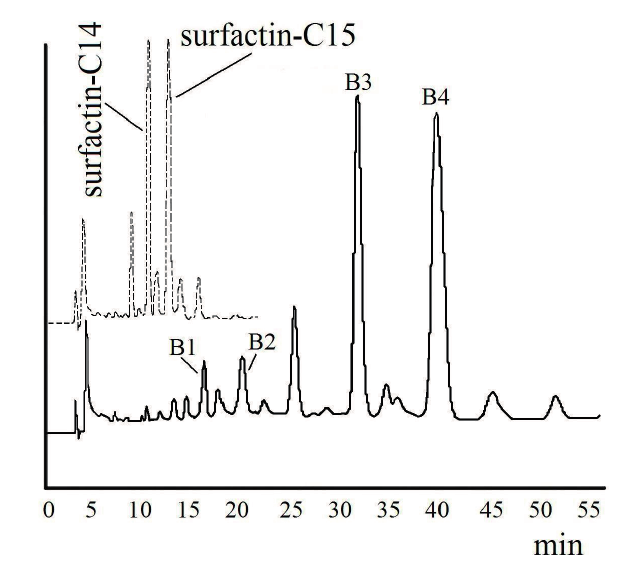
Figure 2. High performance liquid chromatography (HPLC) spectra of surfactin (dashed line) and surfactin-(Glu- γ , Asp- β )-hexyl ester (solid line) under the same